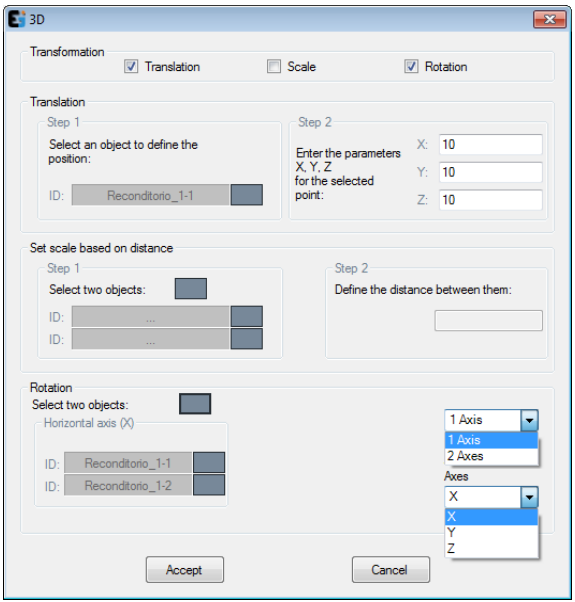
Figure 10. 3D transformation in 3DVEM – GEO: Main window